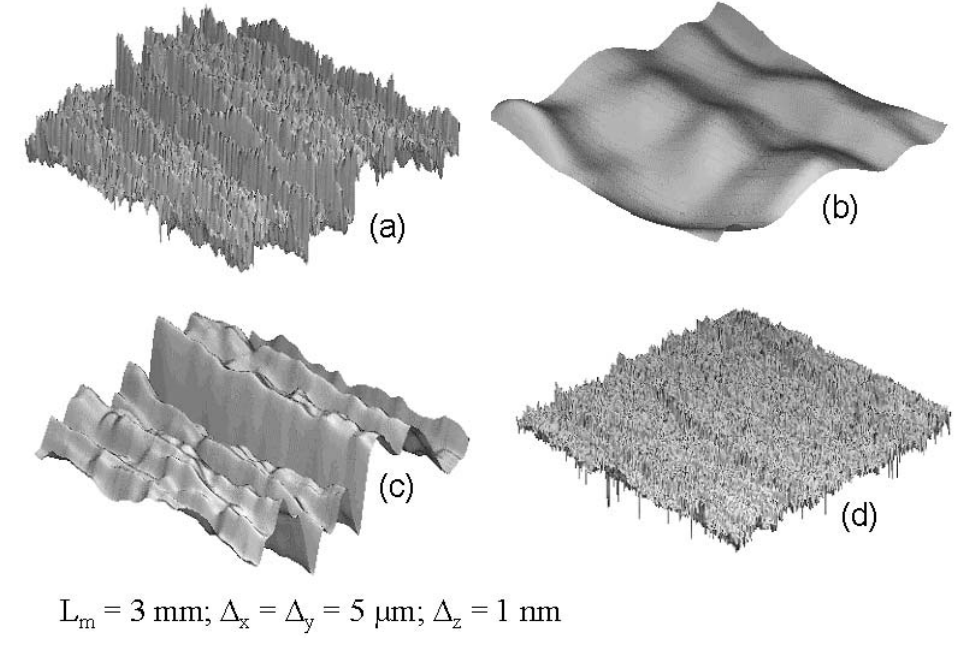
Figure 8 . (a) Total SMC topography. (b) Isolated short waviness. (c) Isolated mean roughness. (d) Isolated arithmetic mean roughness.